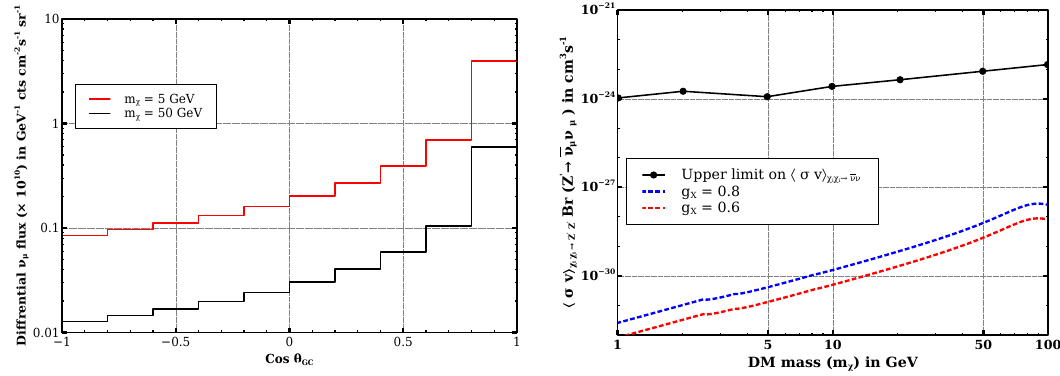
Figure 14 . Left panel : angular variation of differential neutrino flux as a function of cos θ GC for m χ = 5 GeV (red line) and m χ = 50 GeV (black line). Right panel : upper limit on h σv i χχ → Z 0 Z 0 × Br ( Z 0 → ¯ ν µ ν µ ) as a function of m χ for g X = 0 . 6 (red dashed line) and g X = 0 . 8 (blue dashed line). Upper limit on the annihilation cross-section from SK is shown by the black data points. In both the plots, we have considered δ = 10 − 3 . m